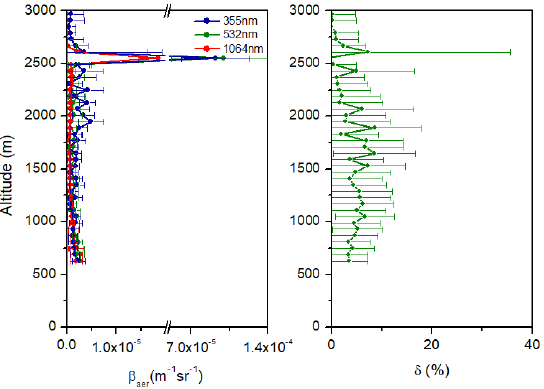
Figure 18. Lidar profiles of aerosol backscattering ( β a ), and linear depolarization ( δ a ) derived from lidar observations carried out on 17 July 2017 in Naples.